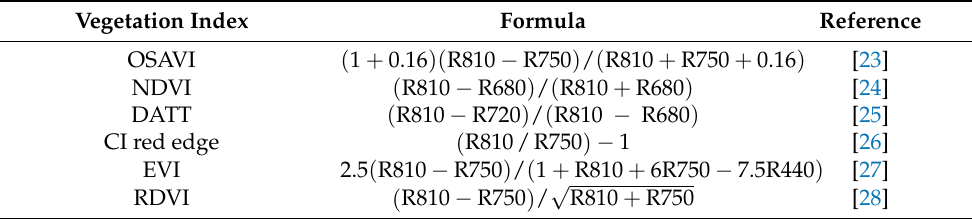
Table 2. Selected vegetation indices in this study for aboveground biomass estimation. Vegetation Index